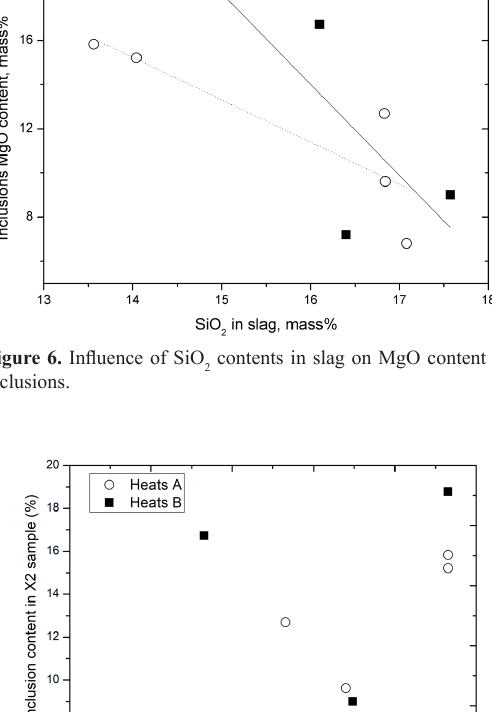
Figure 5. Influence of basicity on MgO content in inclusions according to a) heat groups A and B, and b) to the %CaO/%Al Measured results. Figure 5a is classified according to heat groups A and B and Figure 5b is grouped independently of heat groups A and B, but